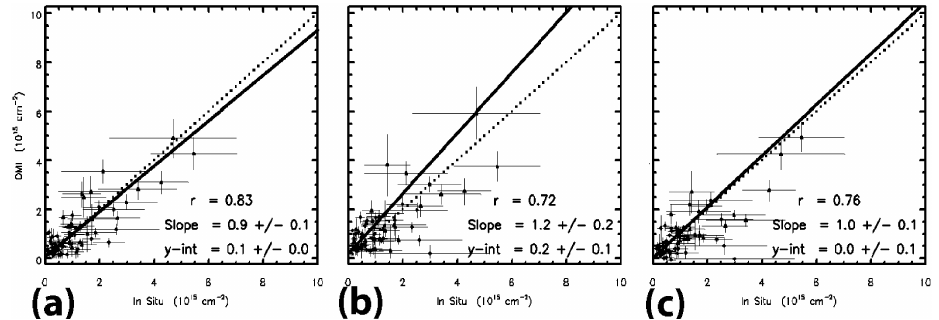
Fig. 10. Comparisons of tropospheric OMI NO 2 retrievals vs. integrated in situ LIF NO 2 measurements obtained during the INTEX-B field campaign over the Gulf of Mexico and clean Pacific locations. Shown are (a) SP1, but with collection 2 slant columns, (b) SP1 (current collection 3), and (c) SP2 (current collection 3). The solid line is an error-weighted least squares fit, and the dotted line is